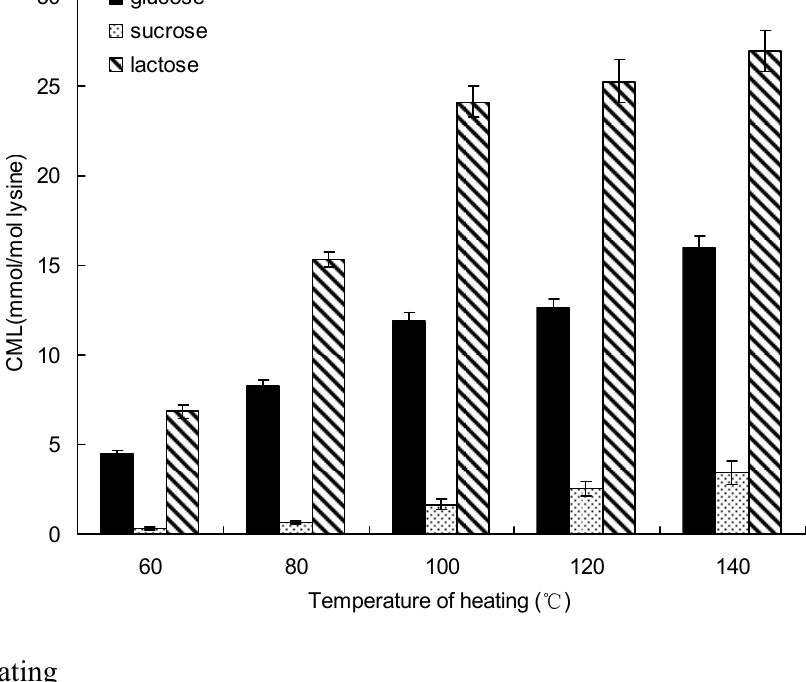
Figure 3. Formation of CML in saccharide-lysine by temperature. Data points are the mean of triplicate measurements ±